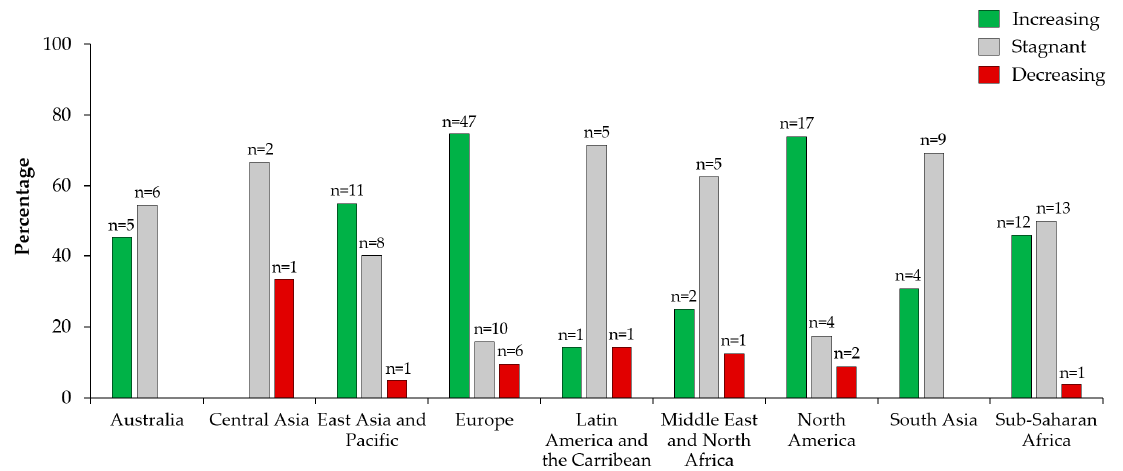
Figure 6. Trends in HIA use perceived by HIA practitioners with experience in the respective